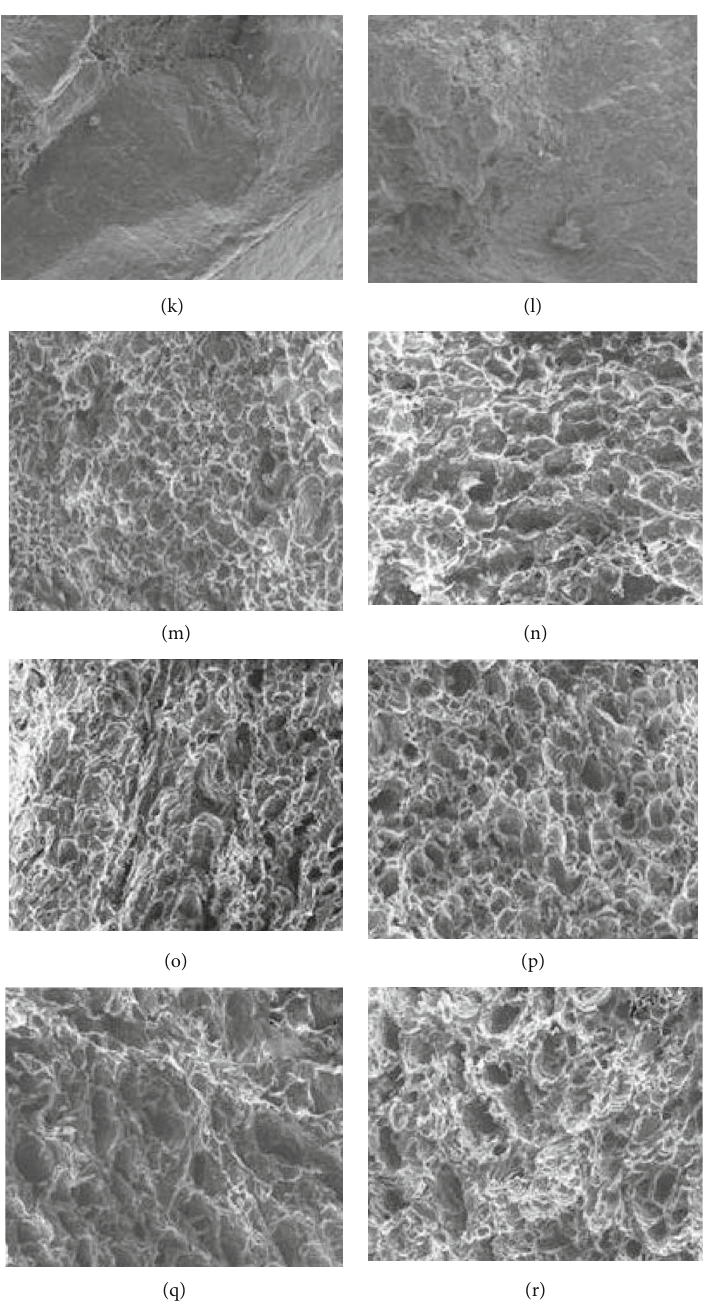
Figure 4: Microstructure of the frozen starch gels containing 0%HDP (a, d, g, j, m, p), 25%HDP (b, e, h, k, n, q), and 50%HDP (c, f, i, l, o, r). The gels were prepared in water (a – f), 45 ° Bx sucrose solution (g – l), or coconut milk (m – r) and subjected to 1 (a – c, g – i, m – o) or 5 (d – f, j – l, p – r) freeze-thaw